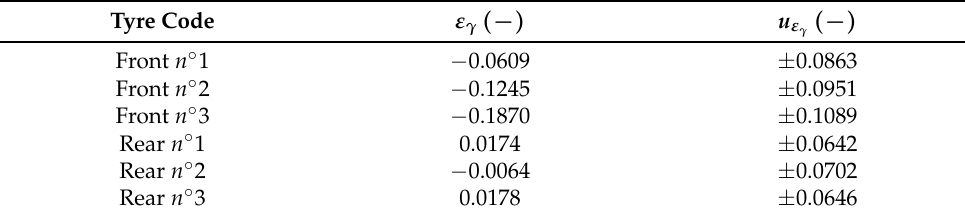
Table 2. Camber reduction factor estimation.